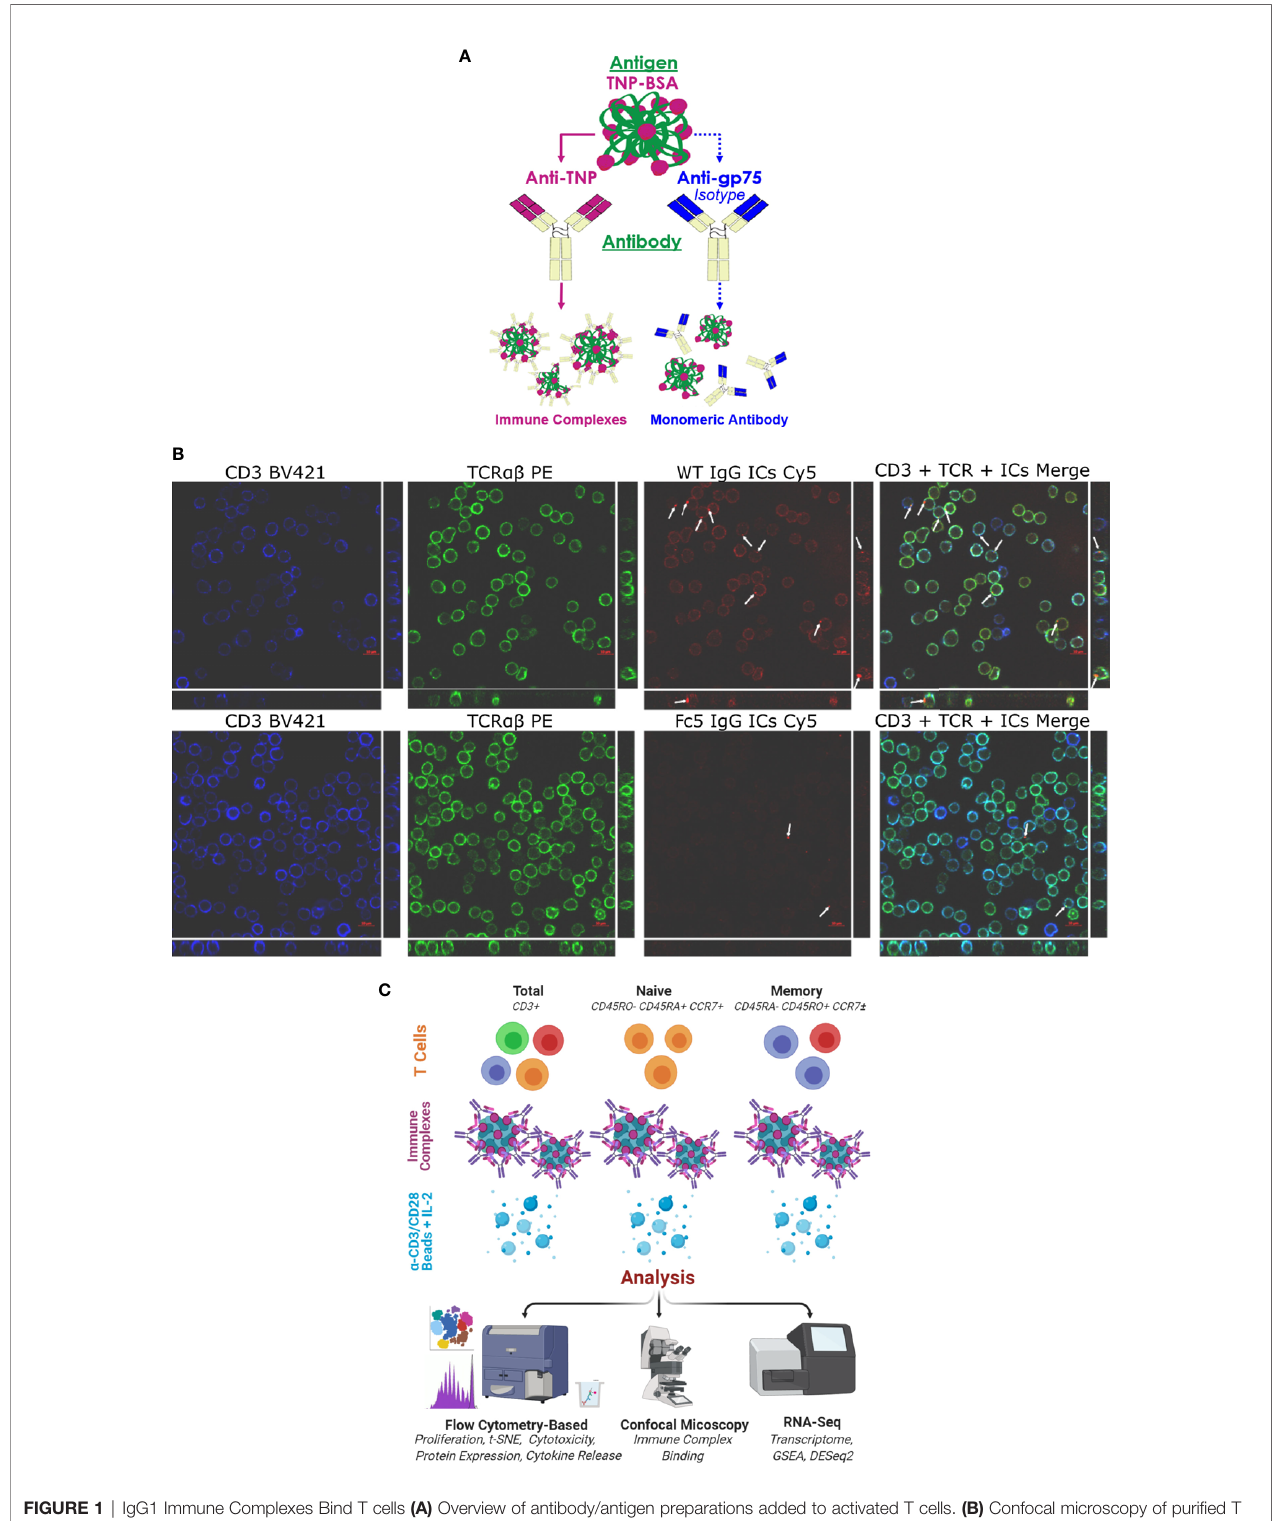
FIGURE 1 | IgG1 Immune Complexes Bind T cells (A) Overview of antibody/antigen preparations added to activated T cells. (B) Confocal microscopy of puri fi ed T cells stained with anti-CD3 (blue), anti-TCR ab (green), and fl uorescent ICs (red). T cells were incubated with either WT IgG1-ICs or Fc5 IgG1-ICs. White arrows show fl uorescent IC clusters. Large and strip images pertain to the x-y and y-z/x-z planes, respectively (C) Schematic overview of experimental protocol. Various T cell subsets are incubated with antibody/antigen preparations; activated with anti-CD3/anti-CD28 beads; and cultured with recombinant interleukin-2 (IL-2). IC-binding experiments were performed on ice using negatively selected, resting CD3+ T